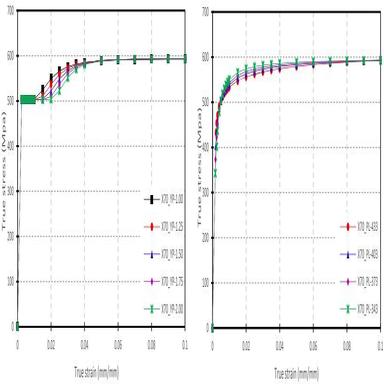
Idealized variations for stress-strain curves of X80-YPT and X80-RHT materials.